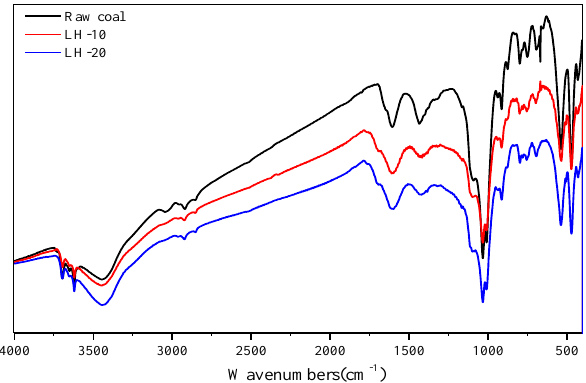
Figure 6. FTIR of the coal before and after heating oxidation at 200 °C.